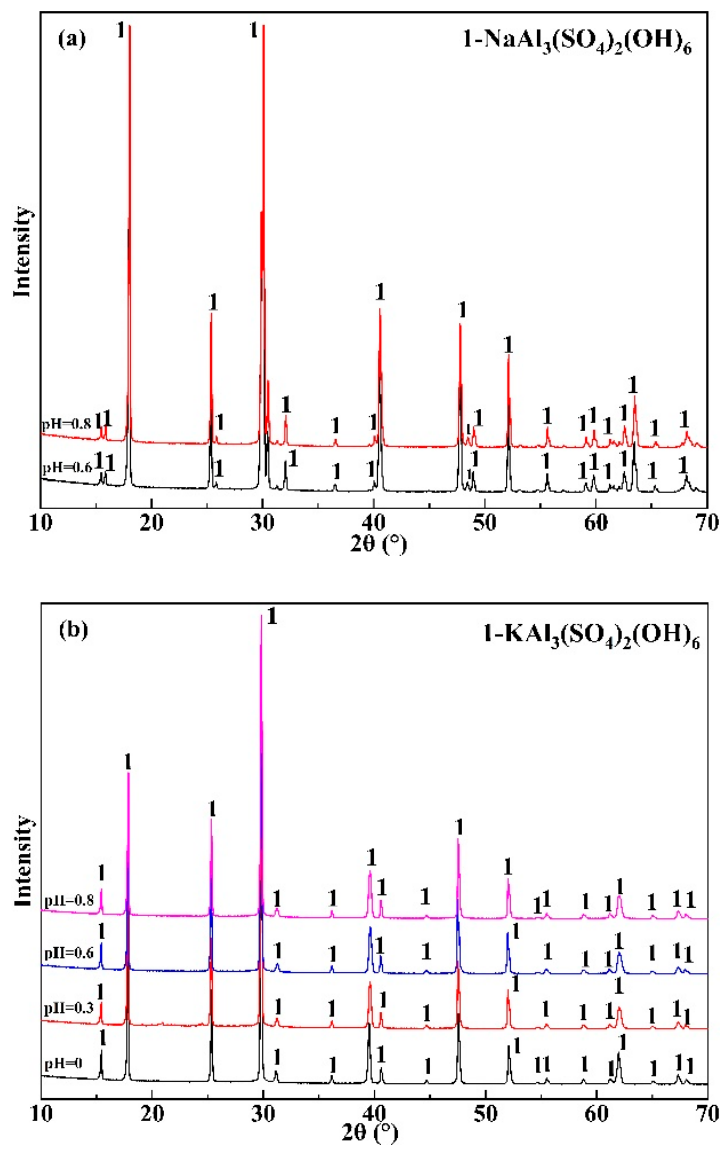
Figure 11. XRD patterns of precipitate obtained by aluminum precipitation experiment: ( a ) Na 2 SO 4 ; ( b ) K 2 SO 4 .